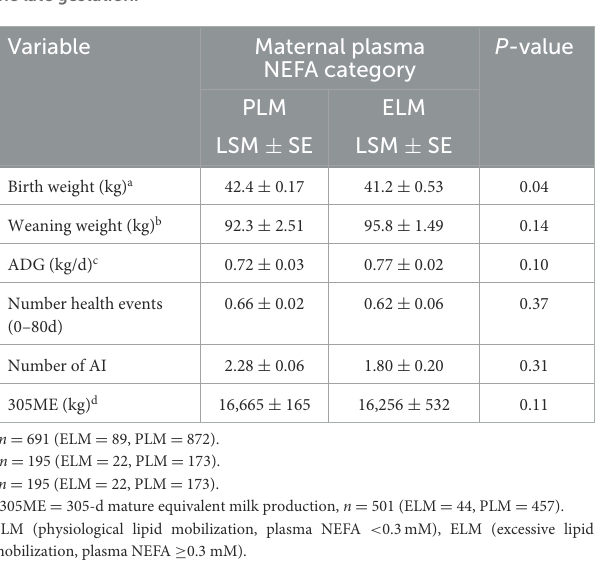
TABLE 3 Least square means for pre-weaned performance, health, reproductive, and productive parameters by maternal NEFA category in the late gestation.